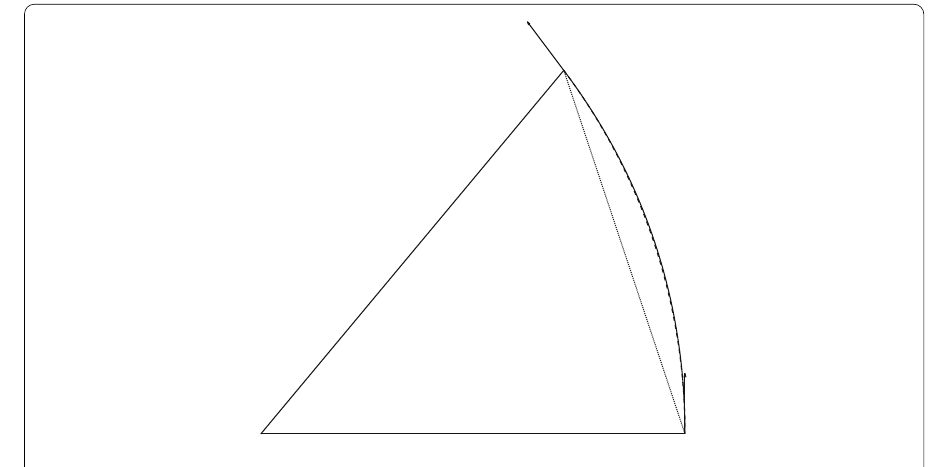
Fig. 4 Cubic spline approximation of the boundary (solid line)